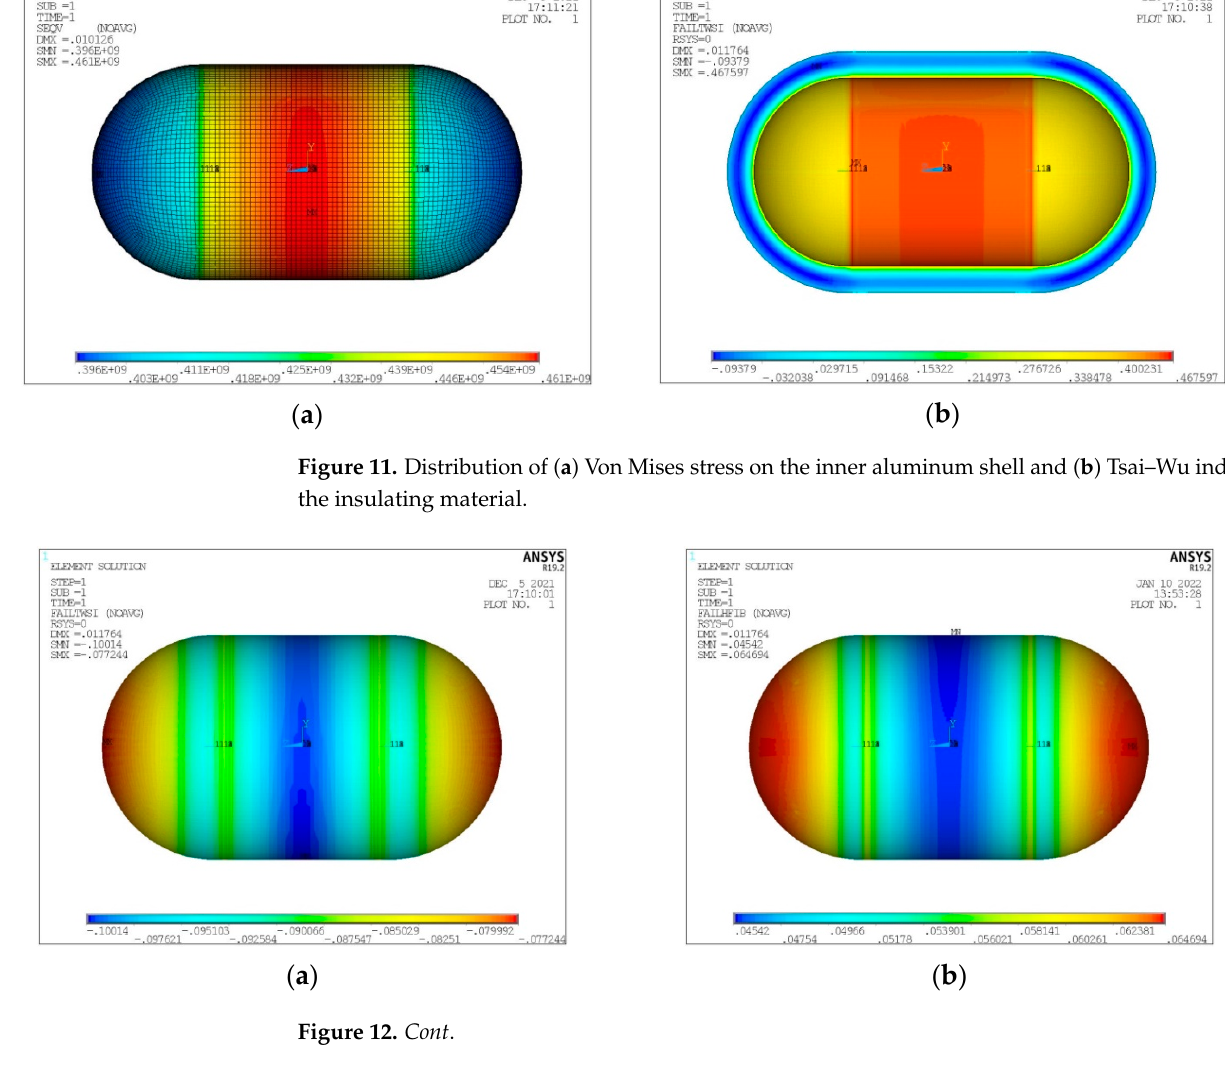
( c ) Figure 12. Distribution of ( a ) Tsai–Wu index, ( b ) Hashin fiber failure criterion and ( c ) Hashin ma- trix failure criterion on the outer composite shell. From the analyses it is observed that, in the case of the aluminum shell, two distinct temperature regions are created: the region of the shell in contact with GH 2 , where the calculated temperatures are in the range of about 25 to about 27 K, and the region of the shell in contact with LH 2 , where the calculated temperatures are in the range of about 23 K to about 25 K. In the case of the insulating material, due to the very large change in temperatures from the side in contact with the aluminum shell to the side in contact with the composite material shell (in total, a change from about 23 K to about 282 K), no sig- nificant difference in the temperature distribution across the thickness of the insulation is depicted. Finally, the outer composite material shell practically does not undergo any significant temperature change, since the difference between its two surfaces is only 0.1 K, and it is not affected by the percentage of fullness of the tank. Regarding the distribution of the heat flow per unit surface (heat flux), it is observed that a thin region of significantly increased heat flux appeared in the aluminum shell at the gas–liquid hydrogen interface, two orders of magnitude above the flux observed across the rest of the surface. In the insulating material, the heat flux varies between 5.18 and 10.58 W/m 2 , with no noticeable correlation with the height of LH 2 in the tank. In the composite shell, the heat flux varies consistently between 5.13 and 5.97 W/m 2 ; however, the area withthe maximum value of 5.97 W/m 2 appears to correlate with the LH 2 level, and more specifically it is located in the area of the cylindrical body of the tank that is in contact with GH 2 . 3.3. Study of the Tanks under Constant Volume of LH 2 In this section a set of different tank designs are examined, which result from dif- ferent values of the geometric ratios λ , φ and ψ , which have already been explained in Section 2. In order to be able to compare the behavior of the different tank configurations,